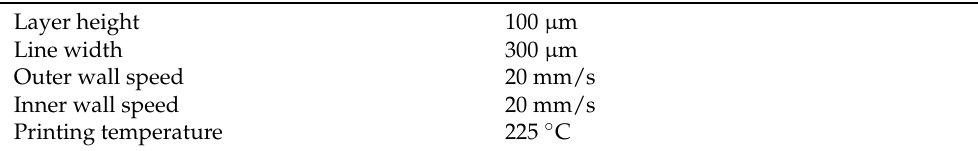
Table 2. For the second printing stage and inherent sterility tests the parameters shown in Table 2 were used. However, the optimal parameters depend on different printers and filaments, which always need to be adjusted